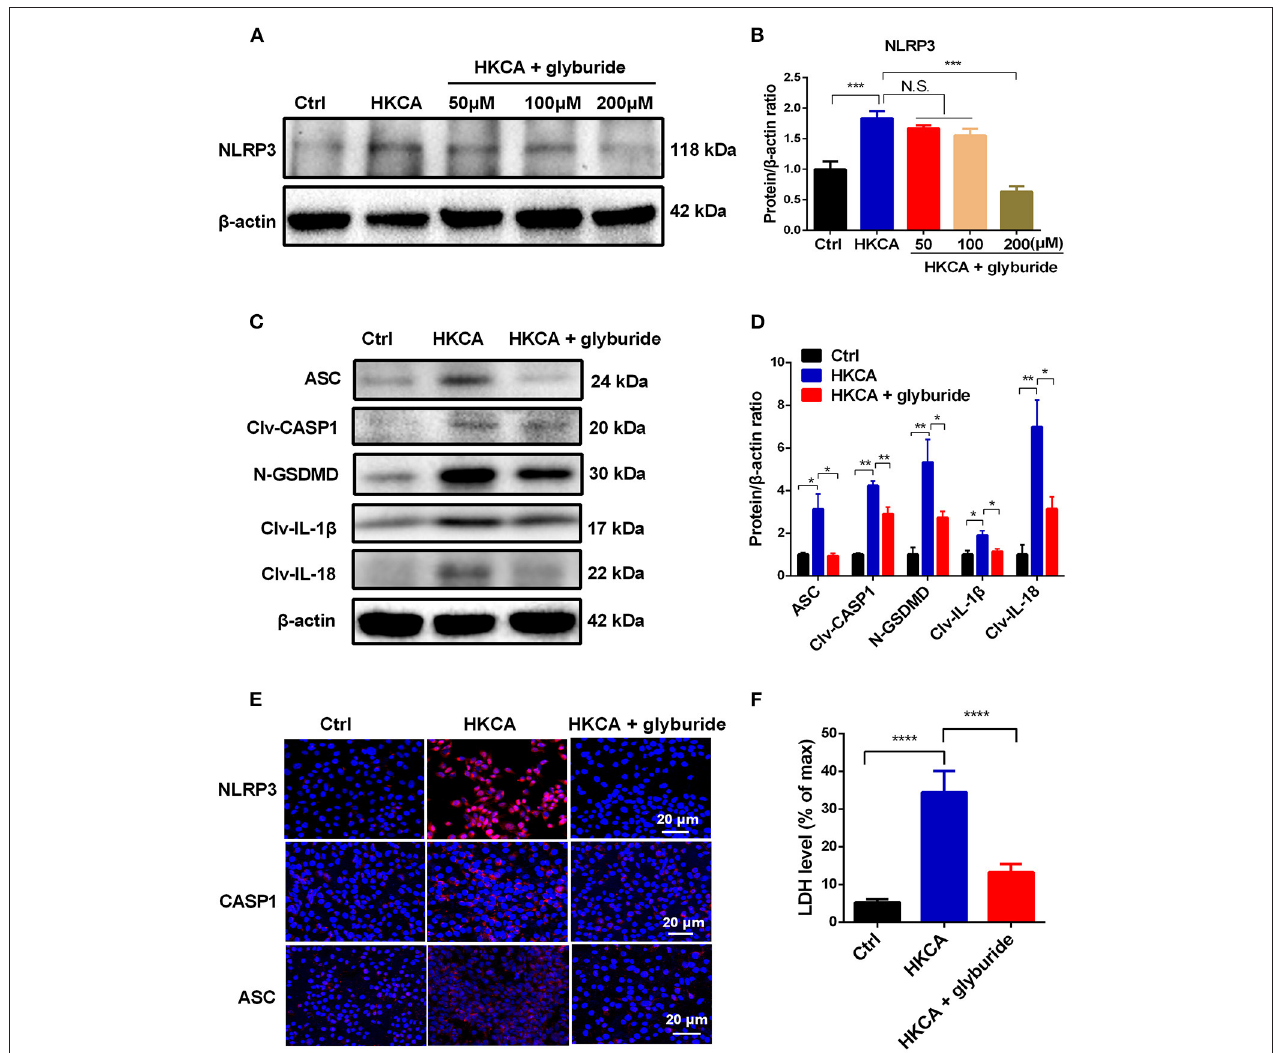
FIGURE 6 | Glyburide attenuates NLRP3 inflammasome-mediated pyroptosis in HCECs infected with HKCA. HCECs were pretreated with potassium (K + ) channel inhibitor (glyburide) for 2h, and then were incubated with HKCA (MOI = 20) for 24h. (A,B) Western blot showing the protein levels of NLRP3 in HCECs treated with various concentrations of glyburide (50, 100 and 200 µ M) ( n = 3). (C,D) Glyburide treatment (200 µ M) suppressed the levels of pyroptosis-related proteins (ASC, cleaved CASP1, N-GSDMD, cleaved IL-1 β and cleaved IL-18) in HCECs challenged with HKCA at 20:1 for 24h ( n = 3). (E) Immunofluorescence analysis of NLRP3, CASP1 and ASC in HCECs pretreated with or without glyburide (200 µ M) for 24h ( n = 3). Scale bar = 20 µ m; magnification 400 × . (F) LDH release of HCECs treated with glyburide (200 µ M) ( n = 6). CASP1: caspase-1; Clv-CASP1: cleaved CASP1; Clv-IL-1 β : cleaved IL-1 β ; Clv-IL-18: cleaved IL-18; N-GSDMD: cleaved p30 form of GSDMD. All values are presented as mean ± SEM. N.S. P > 0.05; * p < 0.05; ** p < 0.01; *** p < 0.001; **** p <